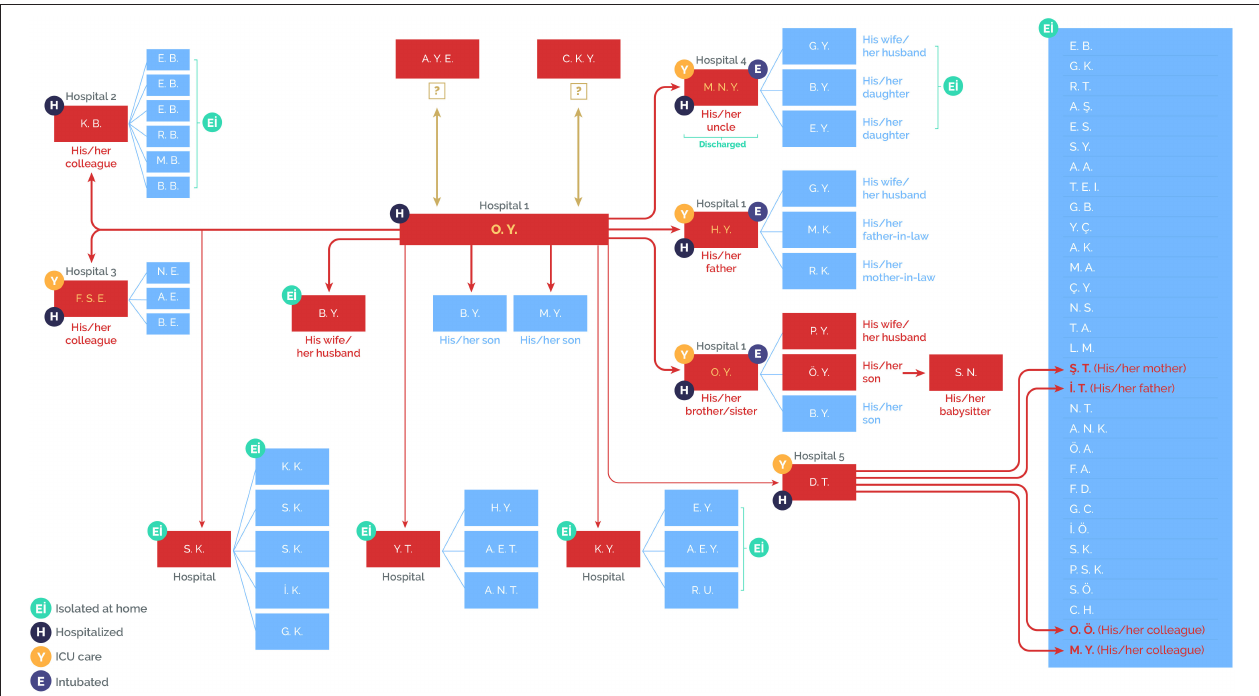
FIGURE 1 | Contact-tracing scheme of the first case in Turkey. Source: Daily reporting from the Directorate General for Health Information Systems, Ministry of Health, Turkey (https://covid19.saglik.gov.tr/?_Dil=2).